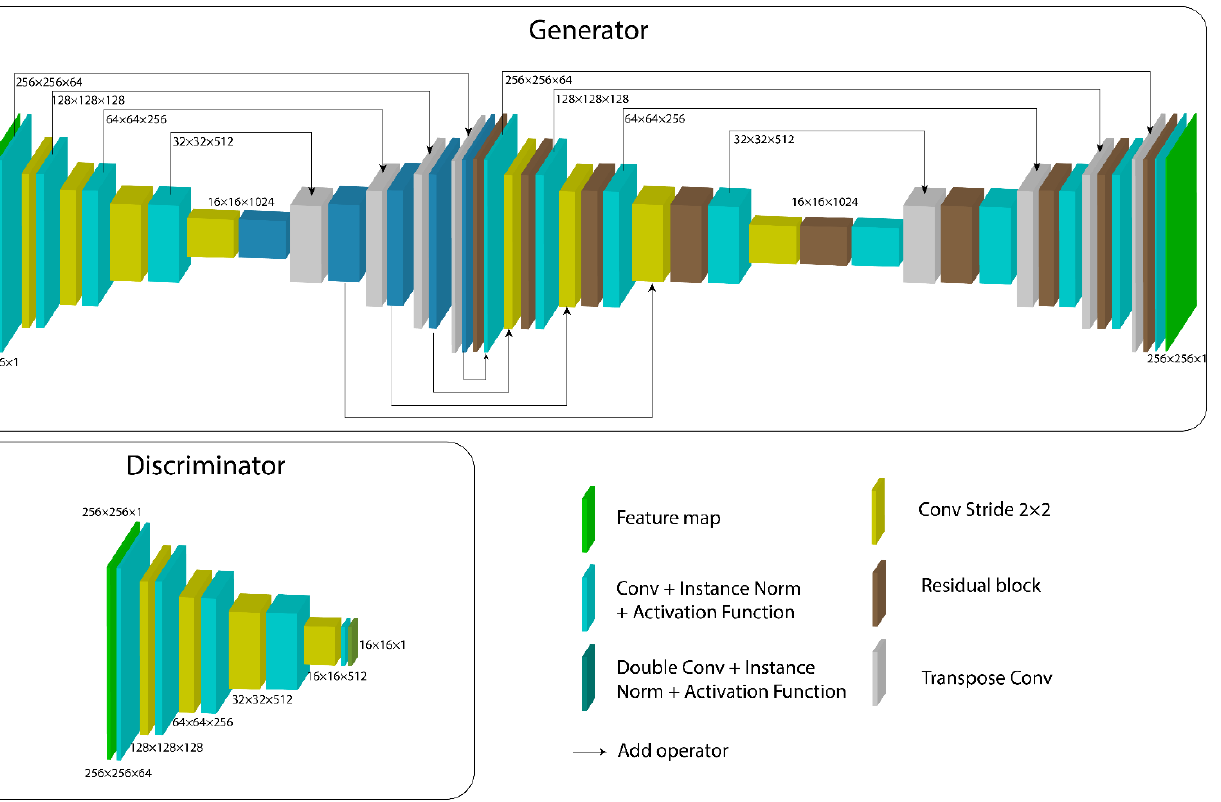
Figure 5. Generator and discriminator models based on [22,30 – 33] for the proposed cGAN architecture. A concatenation of two U-Net-like models inspires the generator. The second one contains residual blocks, which helps preserve and transfer information through deeper layers of smaller details within the feature